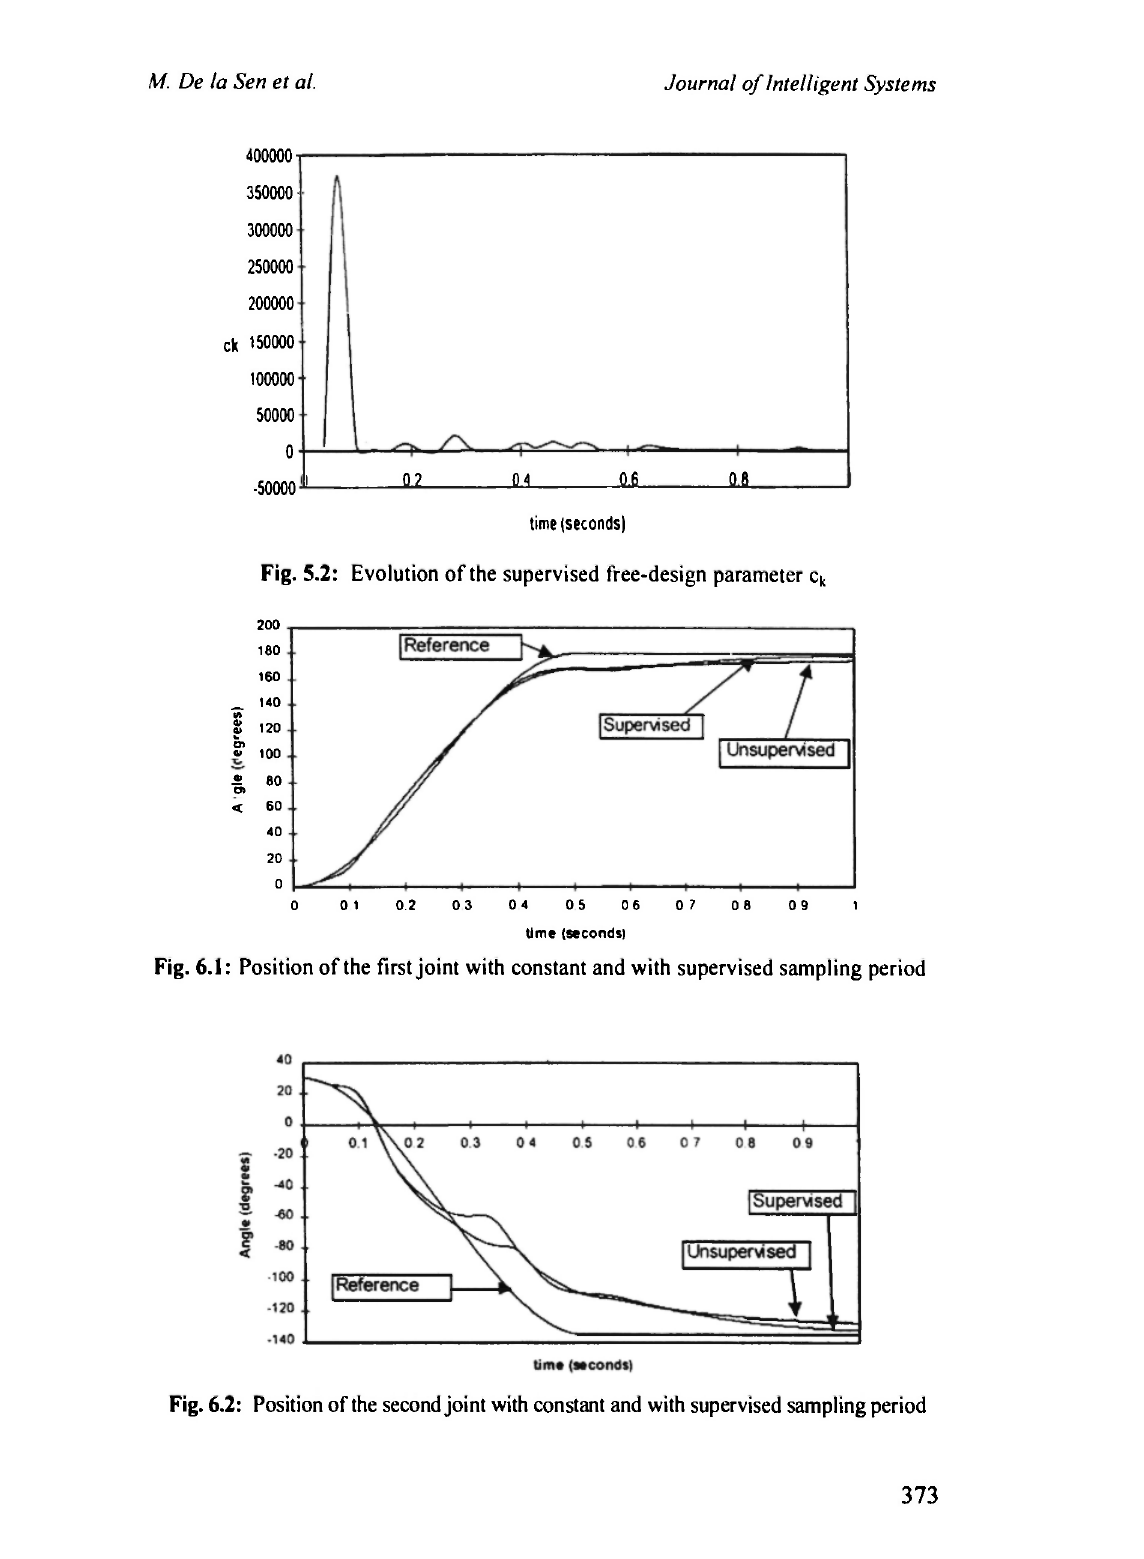
Fig. 6.2: Position of the second joint with constant and with supervised sampling period